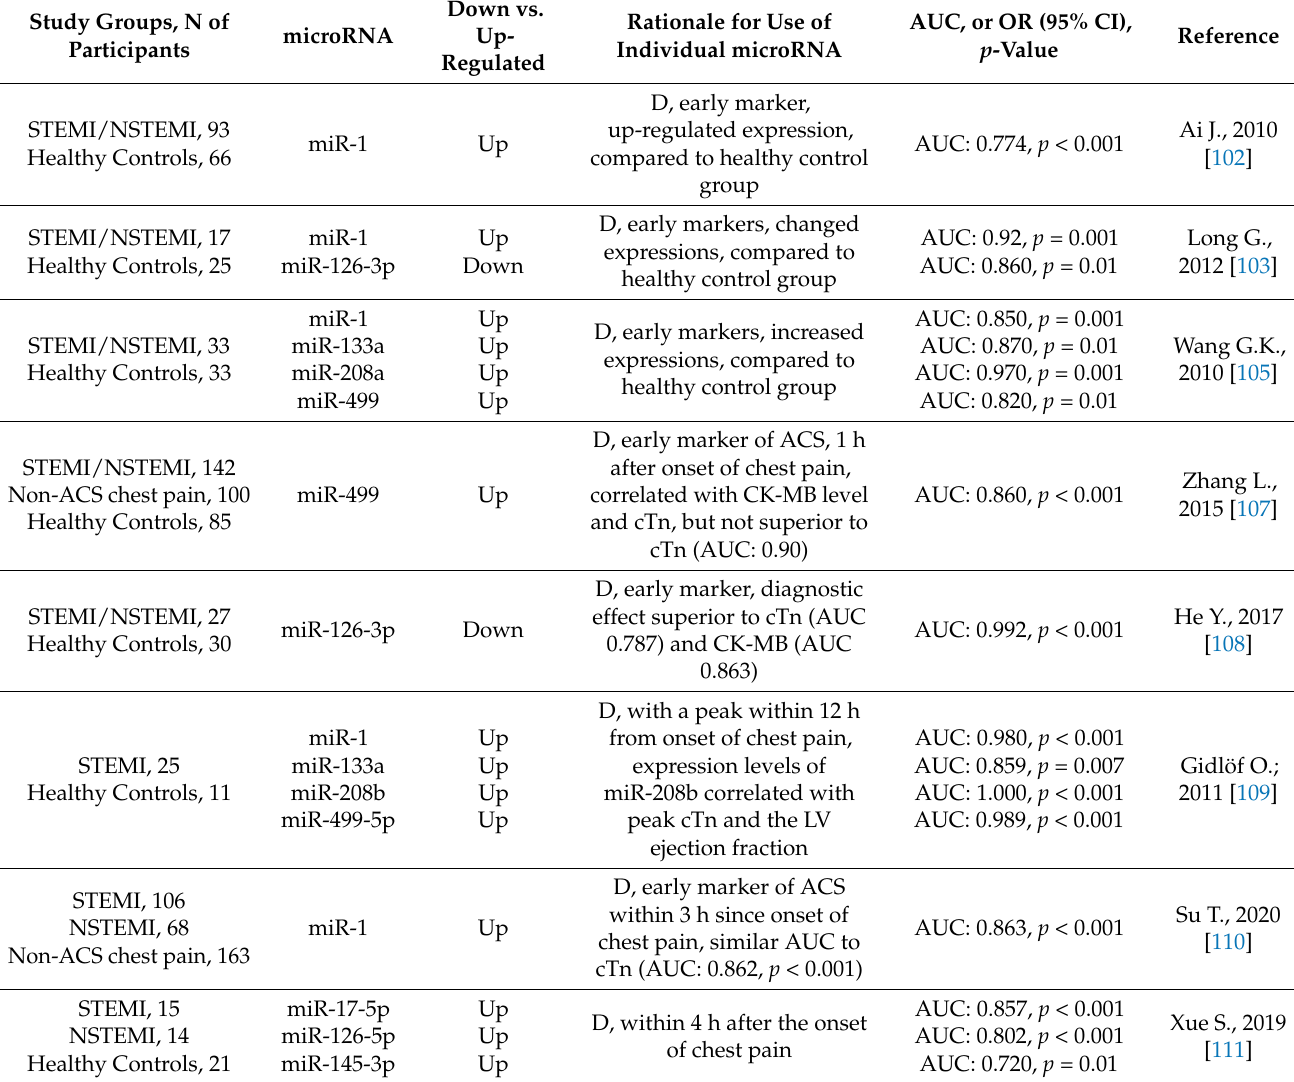
Table 2. microRNAs that are potentially diagnostic in acute coronary